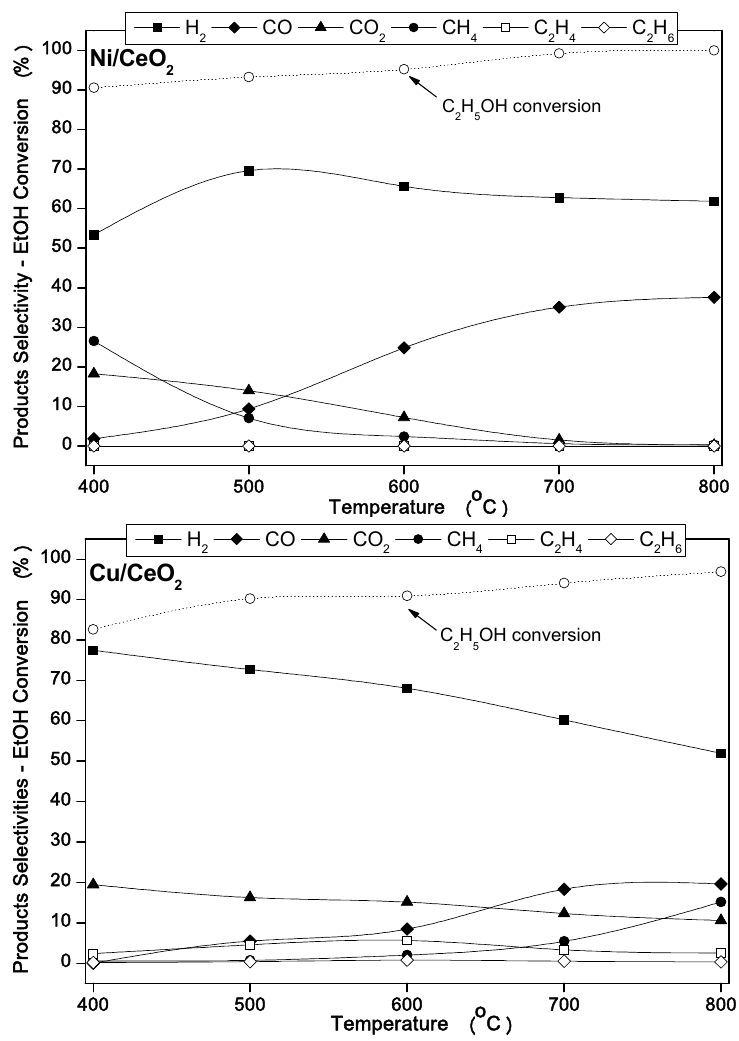
Figure 6. Effect of temperature on product selectivity and C 2 H 5 OH conversion over M/CeO 2 catalysts. Reaction conditions: S/C = 3, m cat = 250 mg, F T = 150 cm 3 /min.